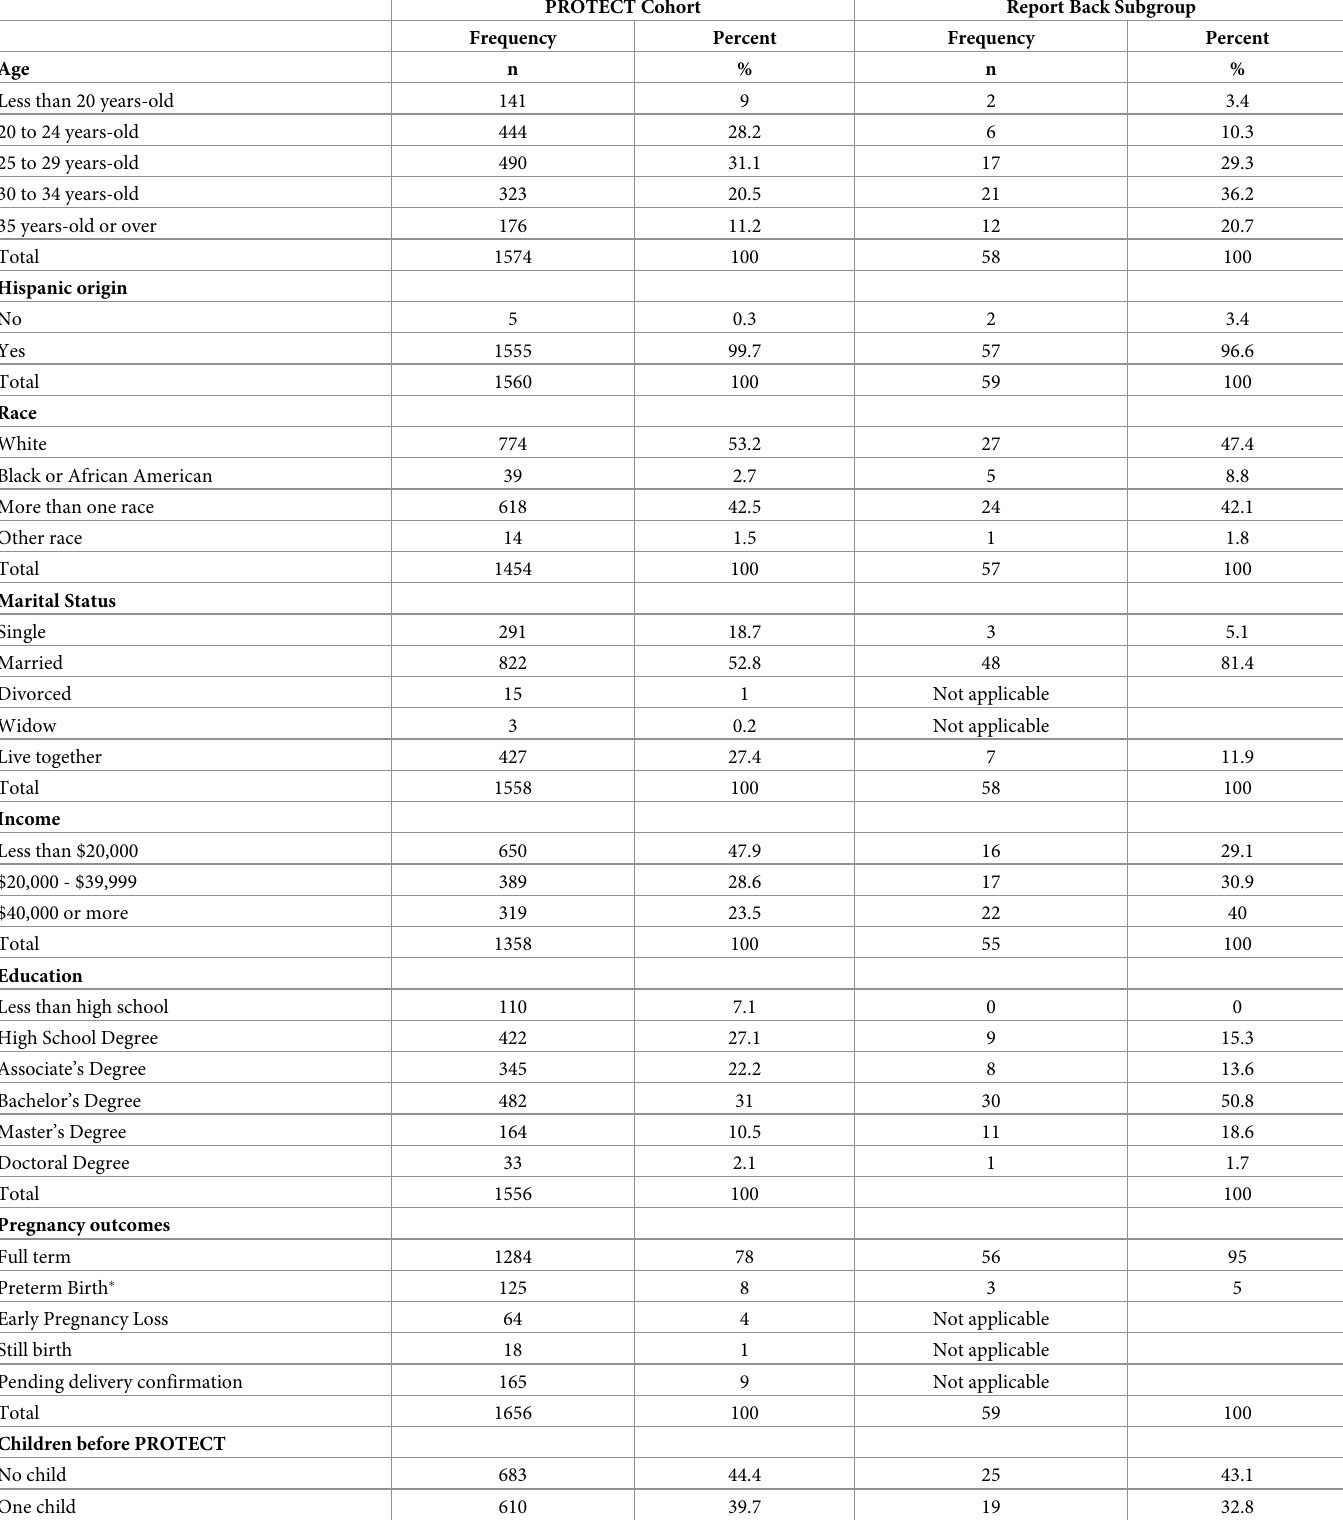
Table 1. Characteristics of PROTECT participants and subgroup of participants in the Report-Back